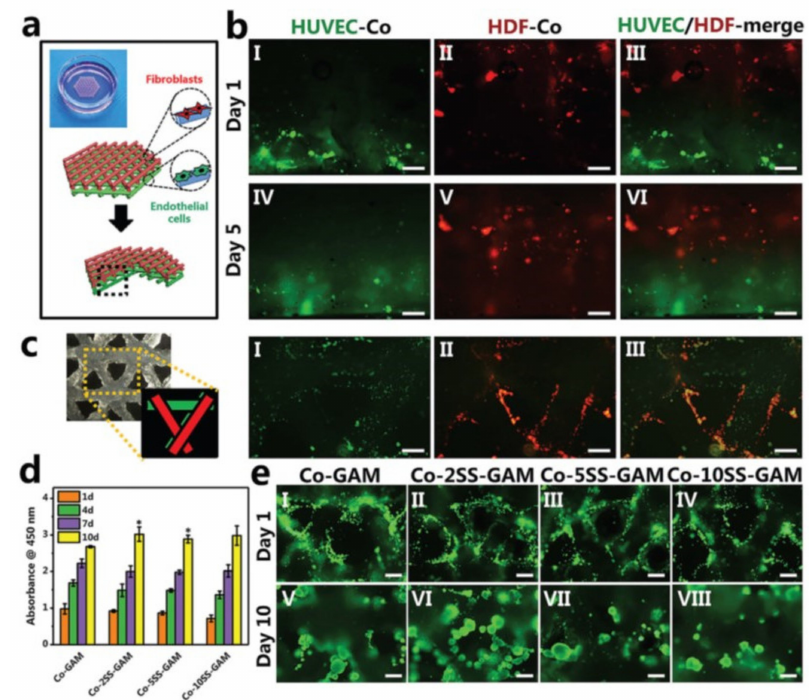
Figure 15. Spatial distribution and proliferation activity of cells in 3D bioprinting Co-SS-GAM biomimetic multicellular scaffolds. ( a ) Schematic illustration of the spatial distribution of HDFs and HUVECs in the Co-2SS-GAM scaffold. ( b , c ) Fluorescence images of the printed cells on the ( b ) vertical section and ( c ) horizontal direction of the scaffolds. HUVECs were labeled with green cell trackers and HDFs were labeled with red cell trackers. After culturing for one and five days, the microscope photographs of (I,IV) HUVECs, (II,V) HDFs, and (III,VI) HUVEC/HDF merged in the same area showed the bilayer distribution of two kinds of cells. Scale bar: 150 µ m. ( d ) Proliferation behaviour of co-cultured cells in the Co-GAM, Co-2SS-GAM, Co-5SS-GAM, and Co-10SS-GAM scaffolds for 1, 4, 7, and 10 days ( n = 3, * p < 0.05). ( e ) Live/dead assay of the co-cultured cells in the scaffolds on